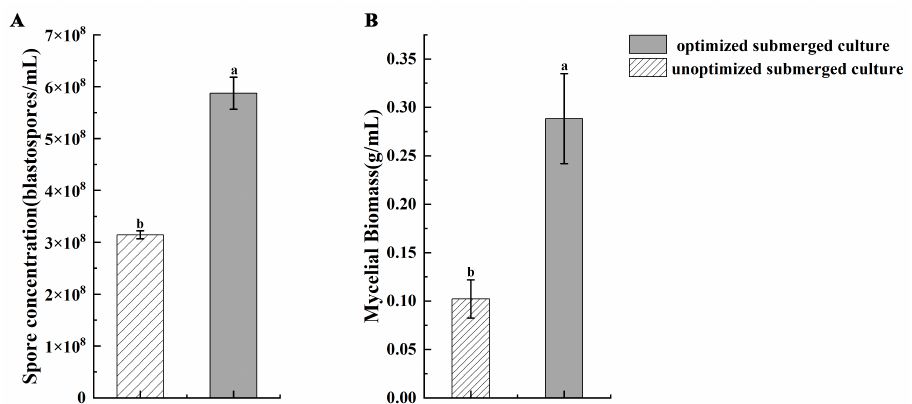
Figure 6. Validation of the statistical optimized submerged culture and unoptimized submerged culture. ( A ) Spore concentration. ( B ) Mycelial biomass. Data in the figure are the mean ± SEM. The SEM of three repetitions is shown in bars. The different lowercase letters (a, b) on the bars indicate a significant difference between different treatments ( p < 0.05, ANOVA with Tukey HSD test).